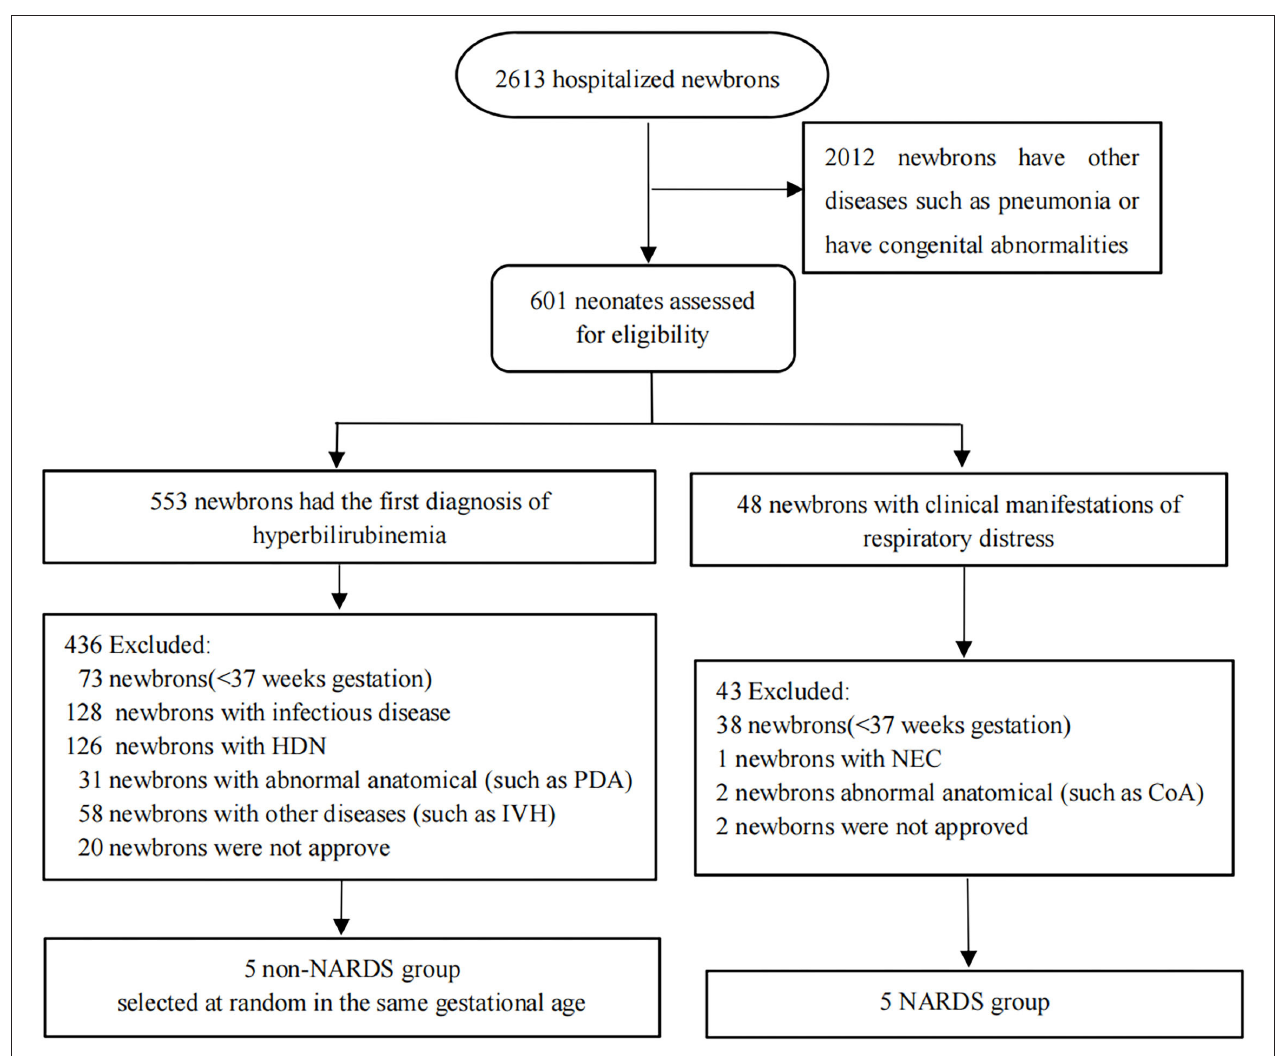
FIGURE 1 | Flow diagram of the patient sample collection applied in the study. In the NARDS group, five newborns were included, and five babies with the same gestational age and only hyperbilirubinemia were selected at random to form a non-NARDS group. HDN, hemolytic disease of newborn; IVH, ventricular hemorrhage; PDA, patent ductus arteriosus; NEC, necrotizing enterocolitis; CoA, coarctation of aorta; NARDS, Neonatal Acute Respiratory Distress